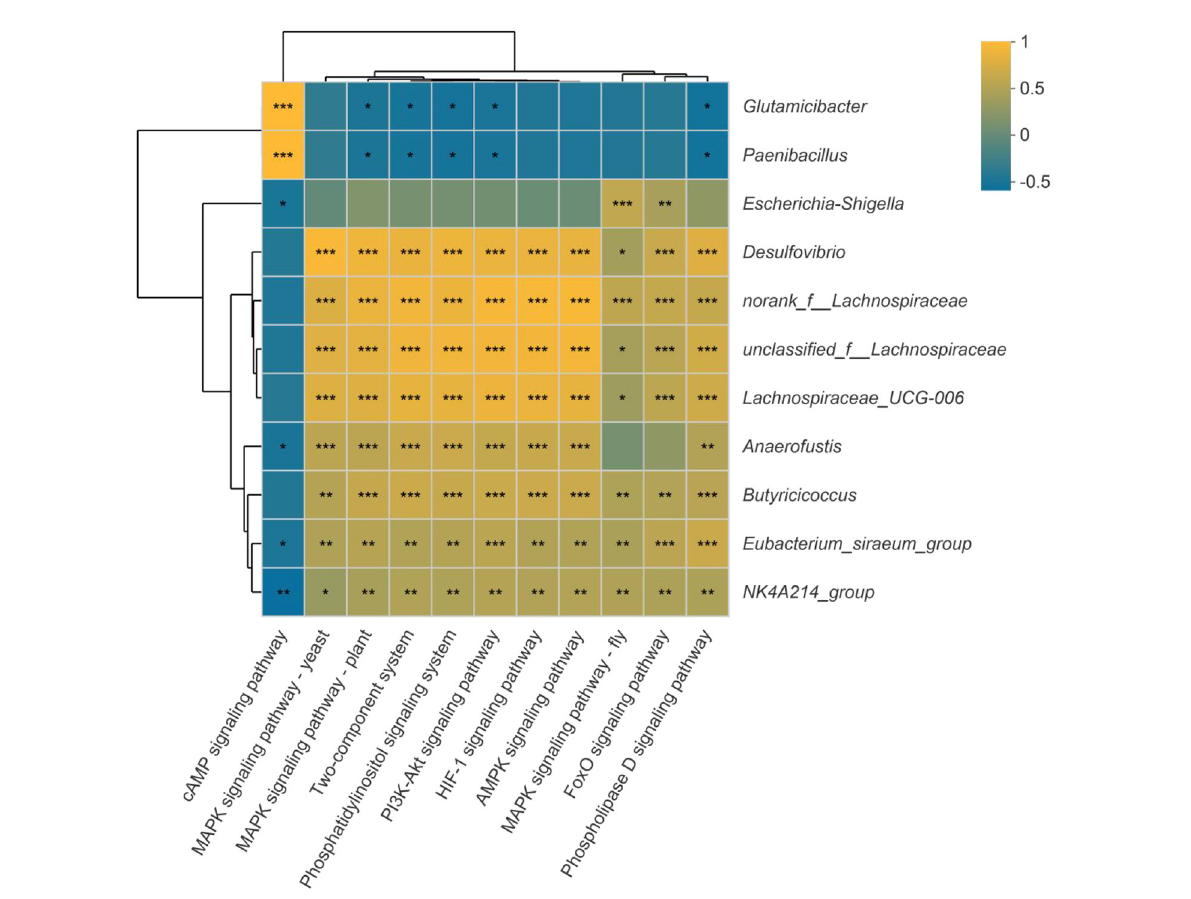
FIGURE11 Correlation between the significantly different genera and signal transduction pathways. Dark yellow reveals a positive correlation, while dark blue reveals a negative correlation. * p < 0.05, ** p < 0.01, *** p <